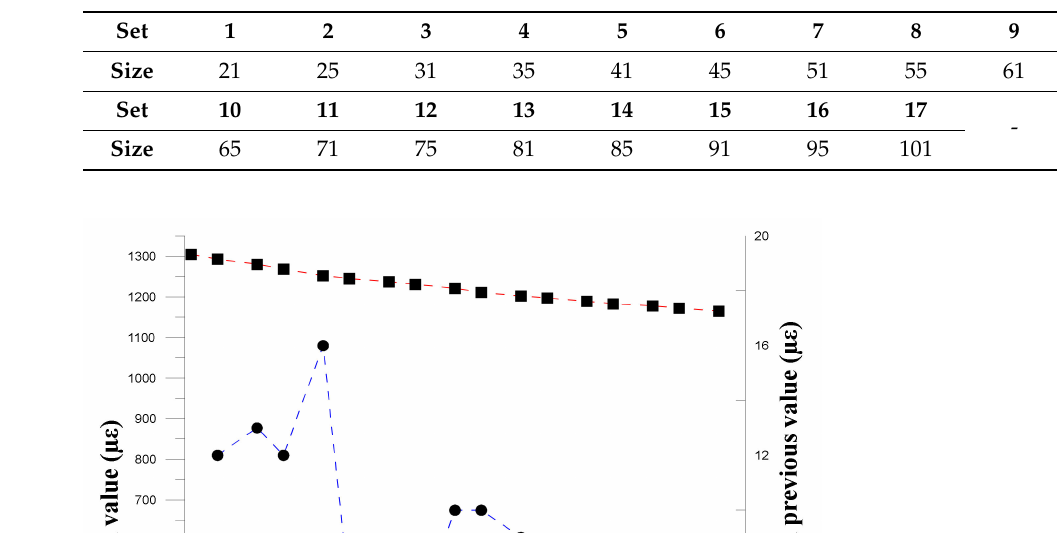
Table 4. Size of the reference subset (unit: pixel).